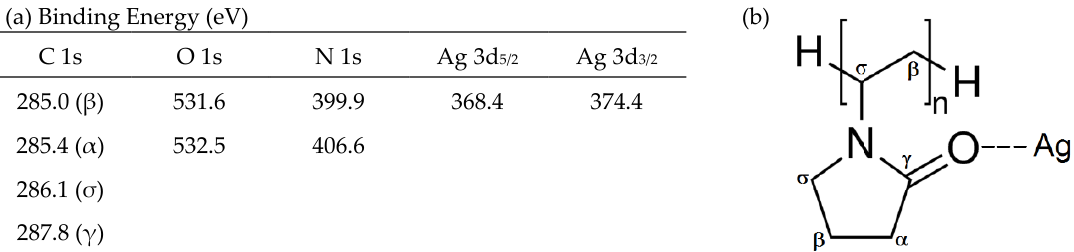
Figure 2. XPS regions of ( a ) C 1s, ( b ) O 1s, ( c ) N 1s, and ( d ) Ag 3d for silver nanoparticle dispersions (AgNP).